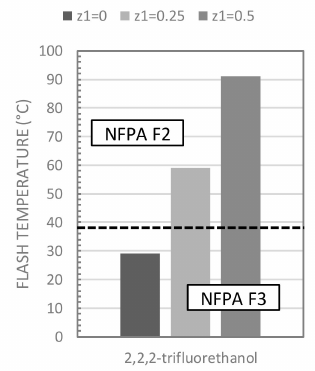
Figure 6. Water / 2,2,2-trifluoroethanol mixture: flash temperature at di ff erent